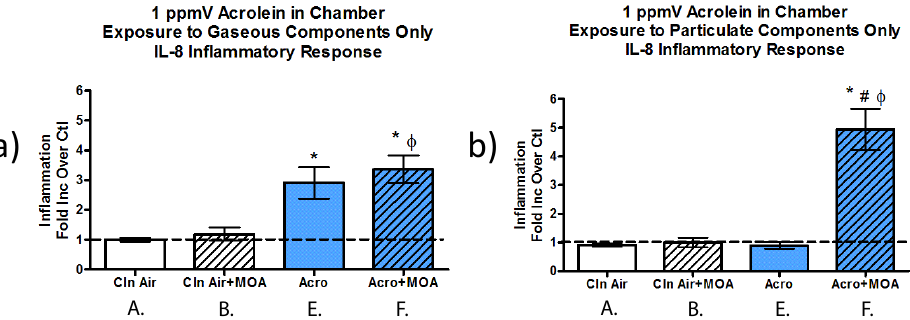
Fig. 6. The IL-8 inflammatory response of lung cells following exposure to four air mixtures. The response induced by exposure to (a) the gaseous components of each mixture and (b) the particle phase components of each mixture.